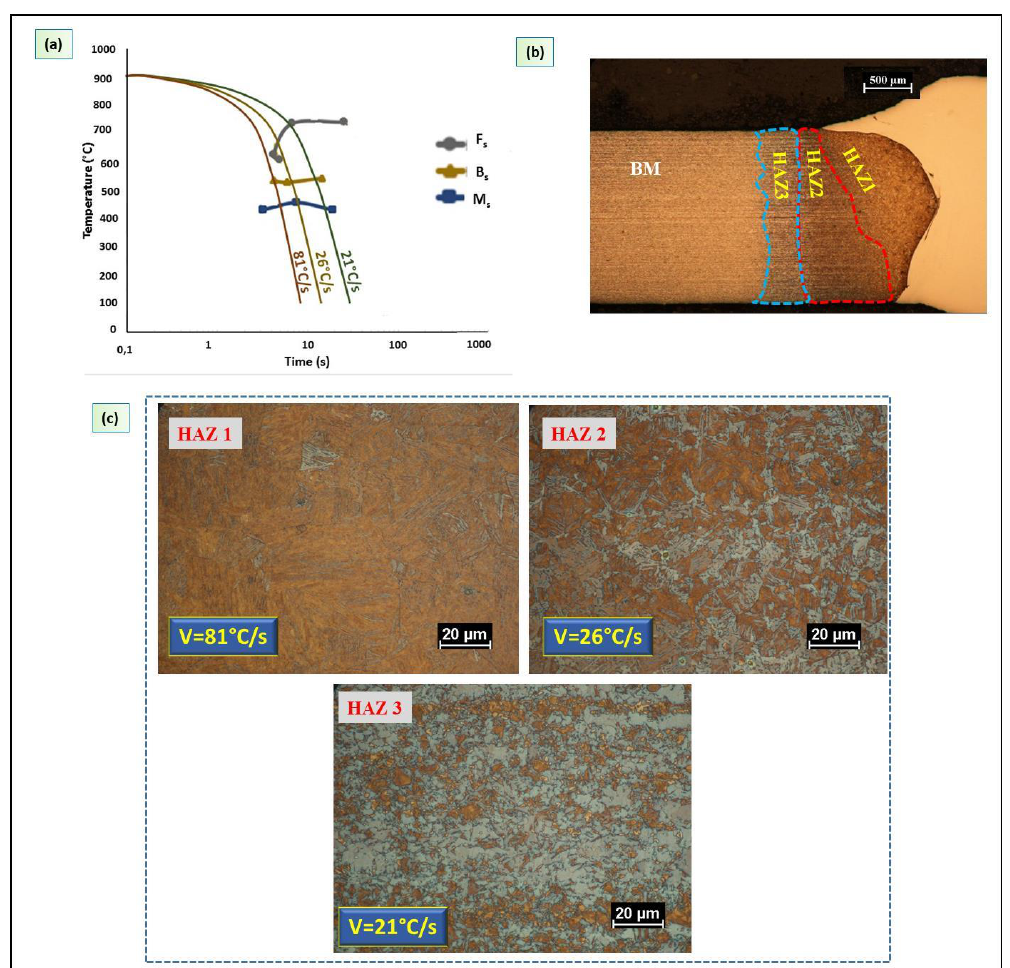
Figure 10. ( a ) Schematic representation continuous cooling transformation (CCT) curve for DP steel; ( b ) three sections of the heat-affected zone (HAZ); ( c ) details of HAZ and their cooling rate.